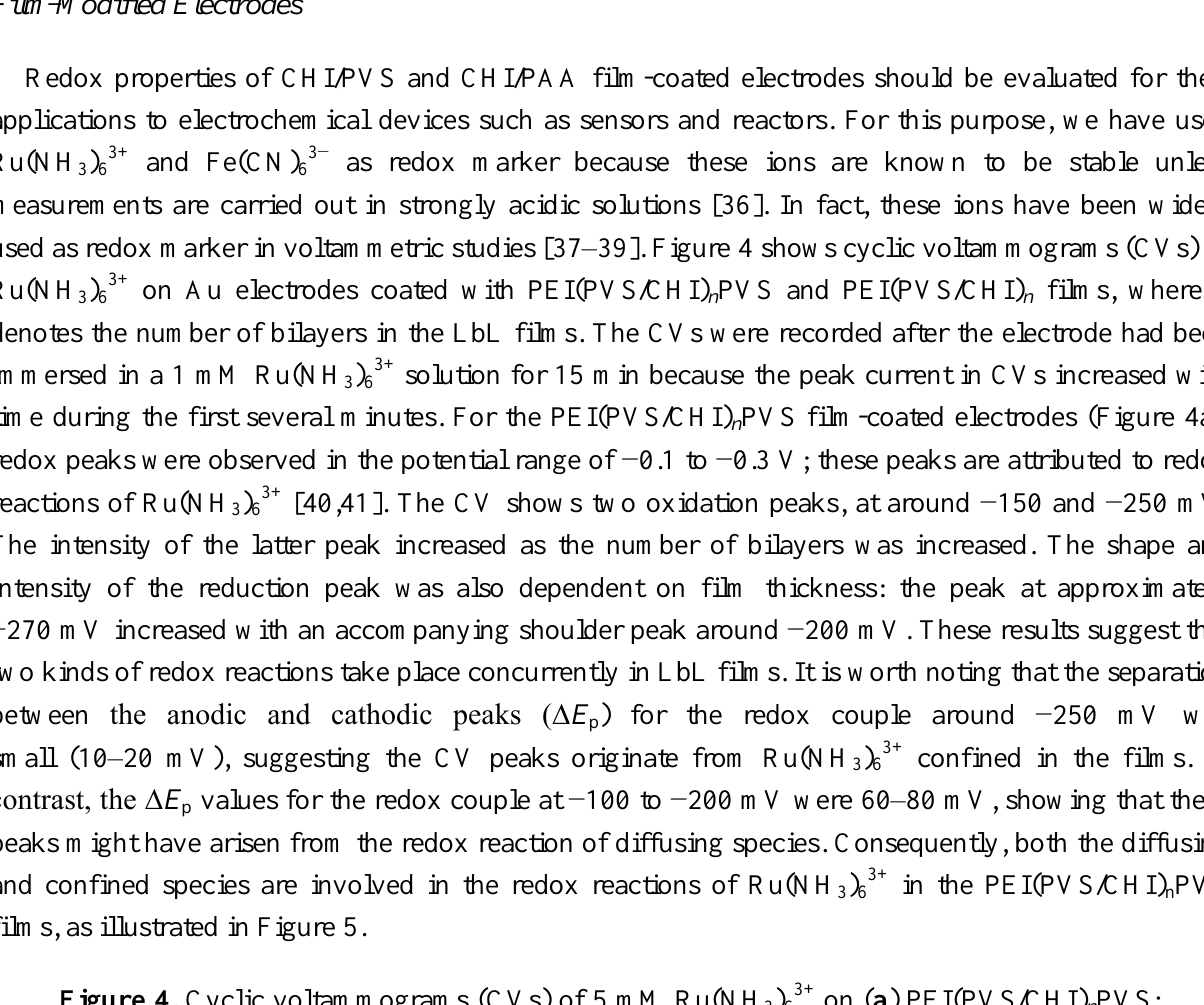
Figure 4. Cyclic voltammograms (CVs) of 5 mM Ru(NH and ( b ) PEI(PVS/CHI)